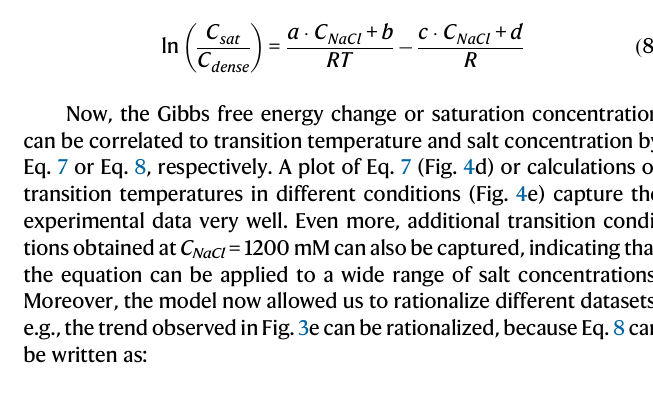
Fig. 3 | Phase separation conditions of prf.GLFG 52×12 . a Illustration of the LCST- type phase separation in this study: At a low concentration, prf.GLFG 52×12 (repre- senting Nup98 FG domains) remains soluble in an aqueous solvent and a single phase was observed. When its concentration is increased to above a threshold termed as saturation concentration, C sat , the amount of protein in the system exceedsthe solvation capacityof the solvent and a synergistic assemblyof protein molecules occurs spontaneously, leading to the formation of a protein-rich “ FG phase ” , which separates from the aqueous phase. FG phase is in form of scattered micrometre-sized spherical particles ( “ FG particles ” ). The solvation capacity of the